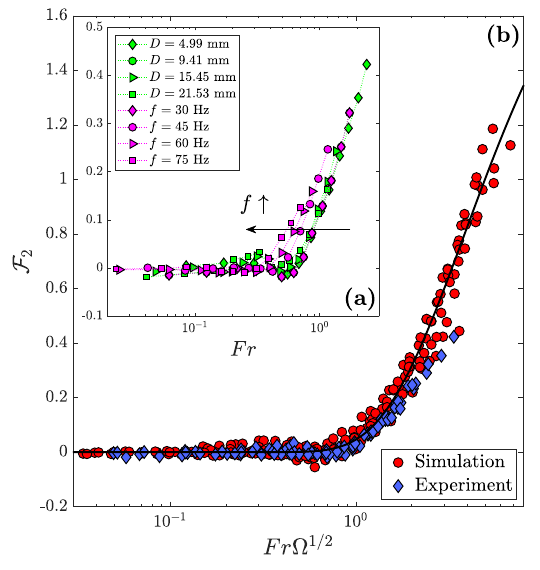
Figure 5. (a) Dimensionless flow rate F 2 as function of the Froude number Fr for the di ff erent opening sizes D = 4 . 99 − 21 . 53 mm ( f = 30 Hz, in green) and frequencies f = 30 − 75 Hz ( D = 9 . 41 mm, in magenta). (b) Dimensionless flow rate F 2 as function of Fr Ω 1 / 2 for all cases in experiment and simulation. The data are fitted to equation 3, with a 2 = 2 . 18 and b 2 = 3 . 86 ( R 2 = 0 .